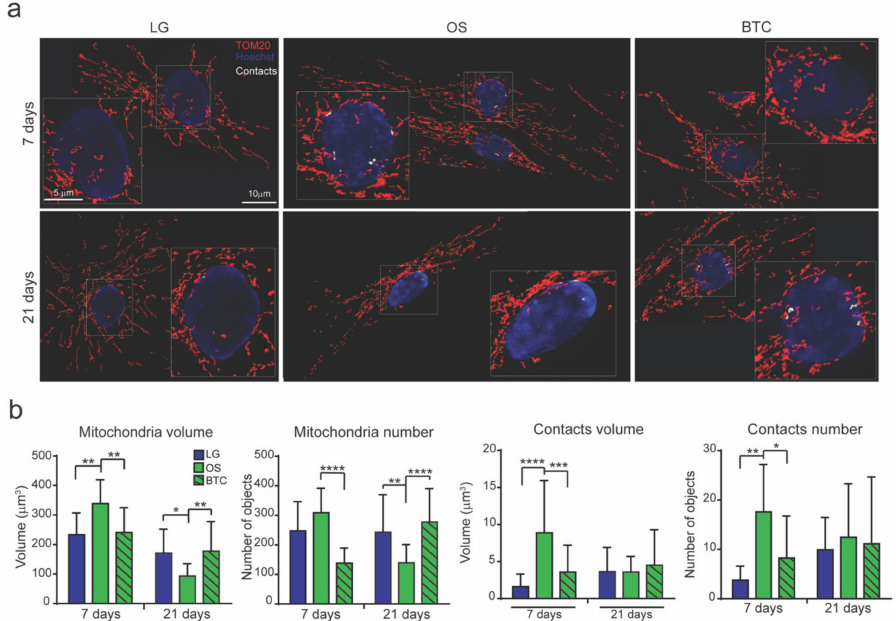
Figure 4. Inhibition of the citrate transport system impaired mitochondrial behavior. MSCs were cultured in low-glucose (LG), adipogenic (AD), and osteogenic (OS) media; where indicated, BTC [5 mM] and iCTP [500 µ M] were added to inhibit the transport of citrate produced in mitochondria to the cytosol. ( a ) Representative images and ( b ) analysis of mitochondrial total volume and number detected by the anti-TOM20 Ab and the total volume and number of mitochondrion-nucleus contact sites. Magnification 40x. Scale bar 10 µ m (in zoom panel, scale bar 5 µ m). Data are derived from ≥ 45 acquired cells / condition from ≥ 3 independent experiments and are shown as the mean ± SD. ANOVA-test. * p < 0.5, ** p < 0.01, *** p < 0.001, **** p <